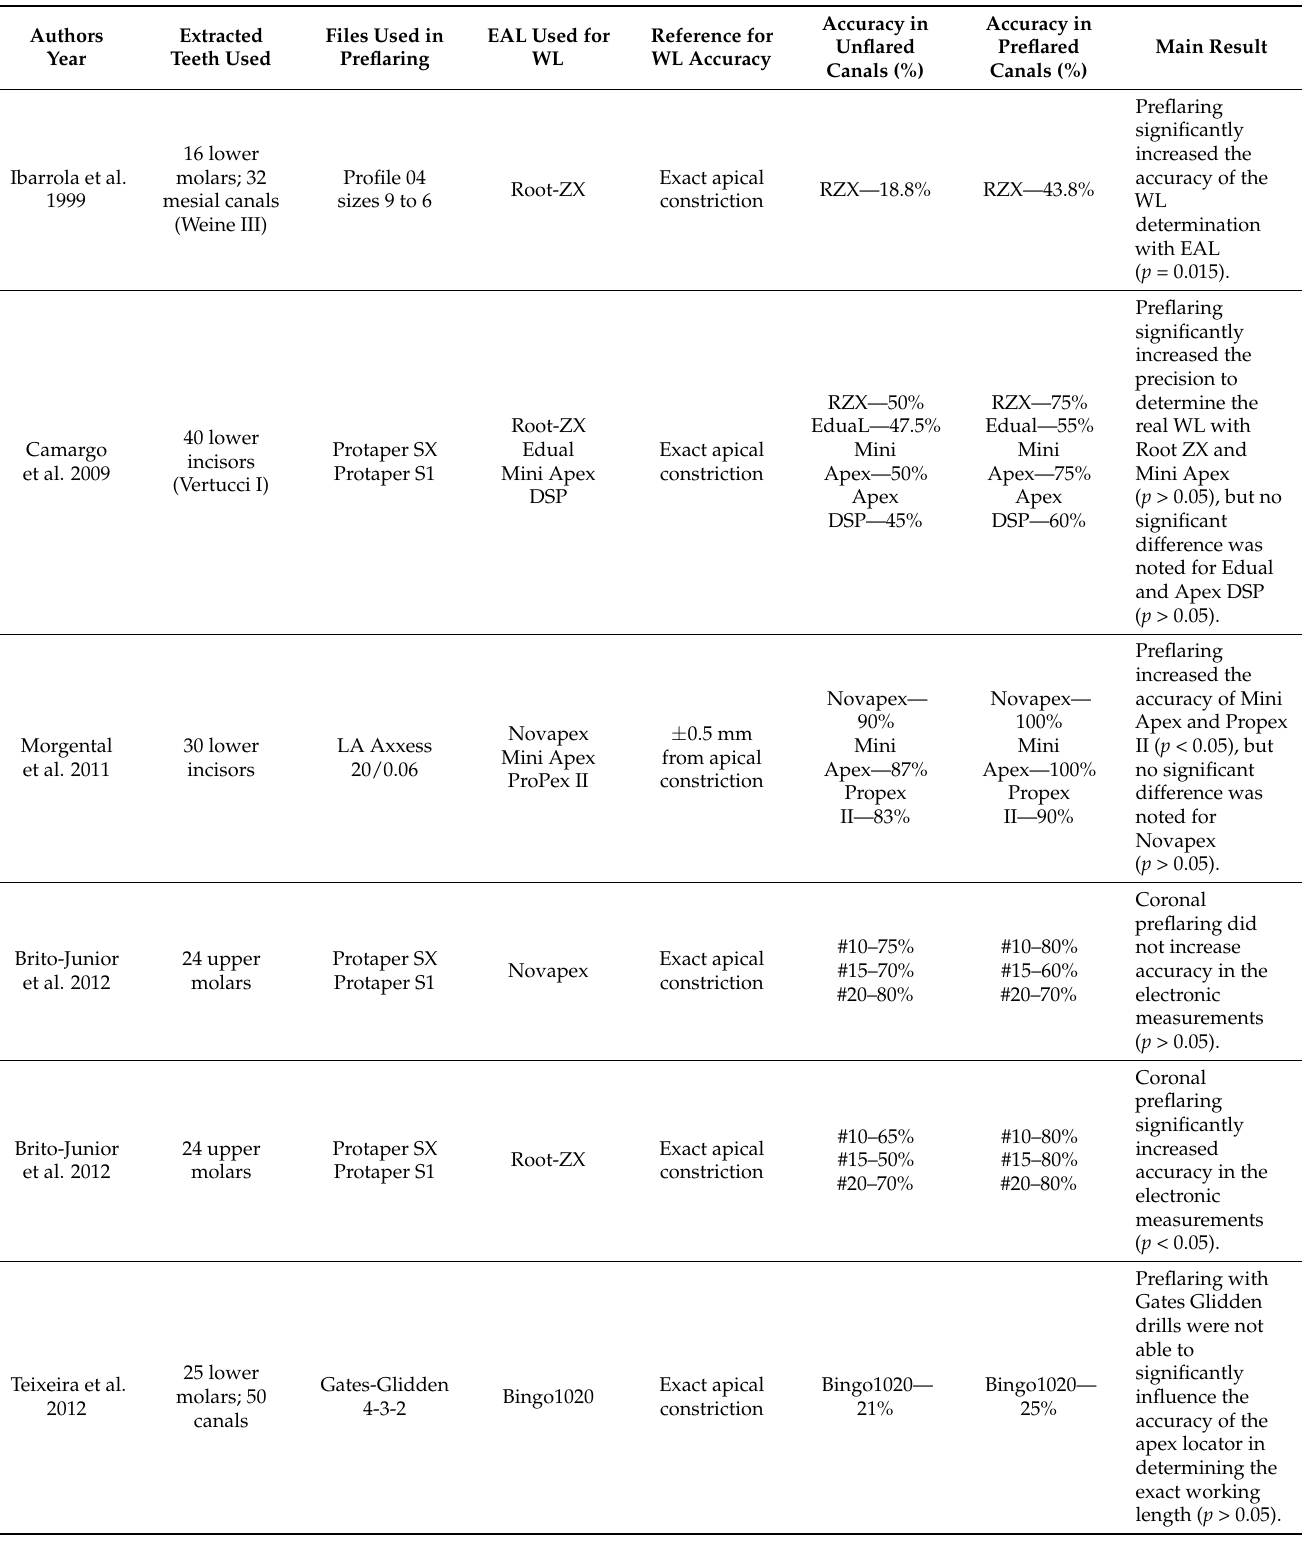
Table 2. Summary of descriptive characteristics of included